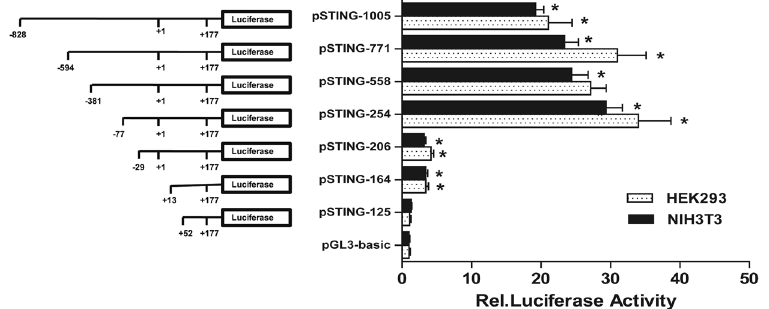
Figure 2. Deletion analysis of the mSTING promoter in NIH3T3 and HEK293 cells. Schematic structures of the mSTING promoter reporter constructs were shown on the left. The numbering was relative to the transcription start site. Seven recombinant reporter plasmids and pGL-3 Basic were cotransfected with the pRL-TK into NIH3T3 and HEK293 cells, respectively. The levels of firefly luciferase activity were normalized to the Renilla luciferase activity. Each bar represented the mean ± SD of three independent experiments (n = 3, * p < 0.05 vs.